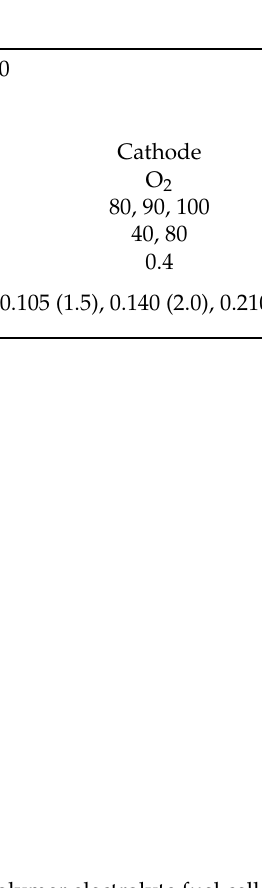
Figure 2. Segment of in-plane temperature distribution in a polymer electrolyte fuel cell, measured by means of a